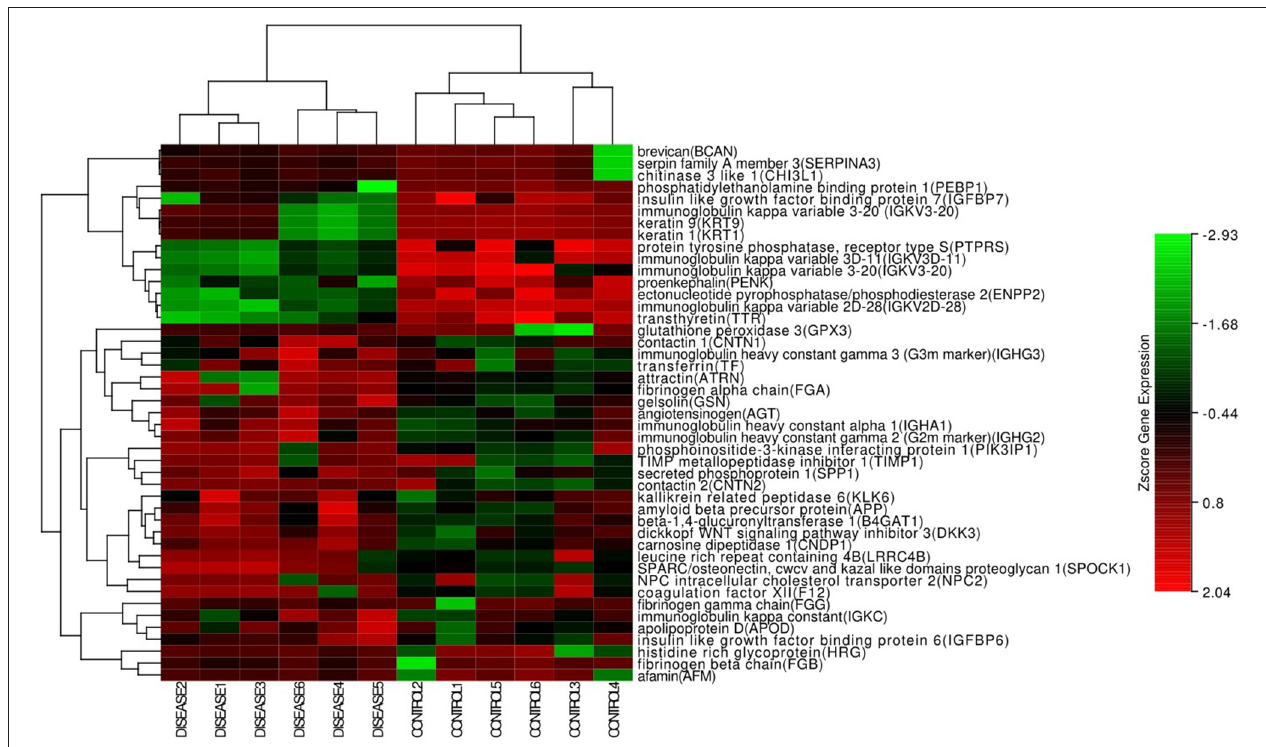
FIGURE 3 | The hotmap of the proteins (Hierarchical clustering of global proteins).